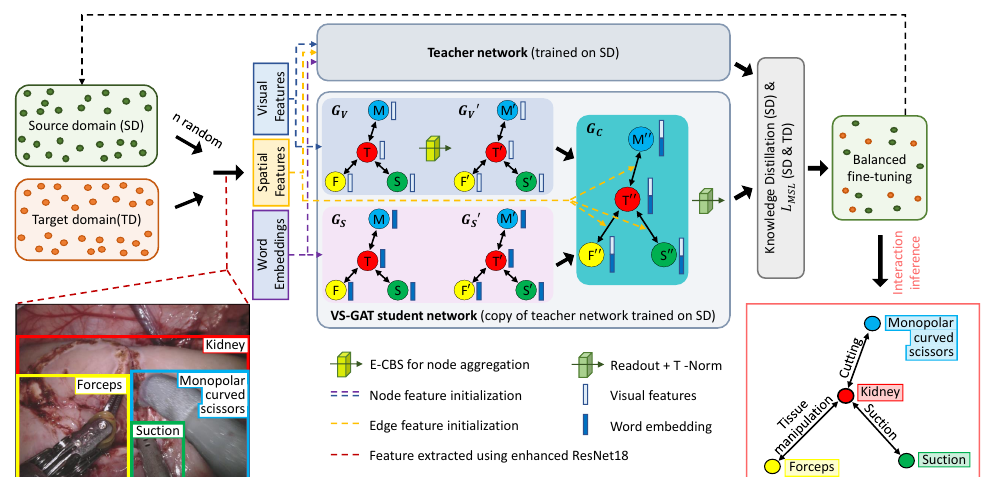
Figure 1. Graph network for surgical scene understanding: Given a surgical scene with bounding boxes, visual features of tissues and instruments are extracted using the FEN. Visual features are embedded in the visual graph ( G v ); nodes and node names are embedded in the semantic graph ( G s ) nodes. To improve graph network performance, E-CBS is appended to G v ’s node aggregation. Upon node aggregation in both graphs, they are combined to form G c , having edges embedded with spatial features. Upon G c aggregation, the readout function processes the edge features to predict interaction logits which are then temperature normalized. Incremental DG: Given a model trained on source domain, DG is achieved in 2 tiers. Firstly, the FEN is naively trained using IL [12] to include novel instruments and domain shifts. Secondly, the graph network is domain generalized based on the student–teacher training regime in knowledge distillation. A graph network initially trained in the source domain is considered the teacher model. A copy is then taken as a student model and further trained on the target domain and random samples from the source domain. Finally, the student model is fine-tuned on a balanced distribution from the source and target